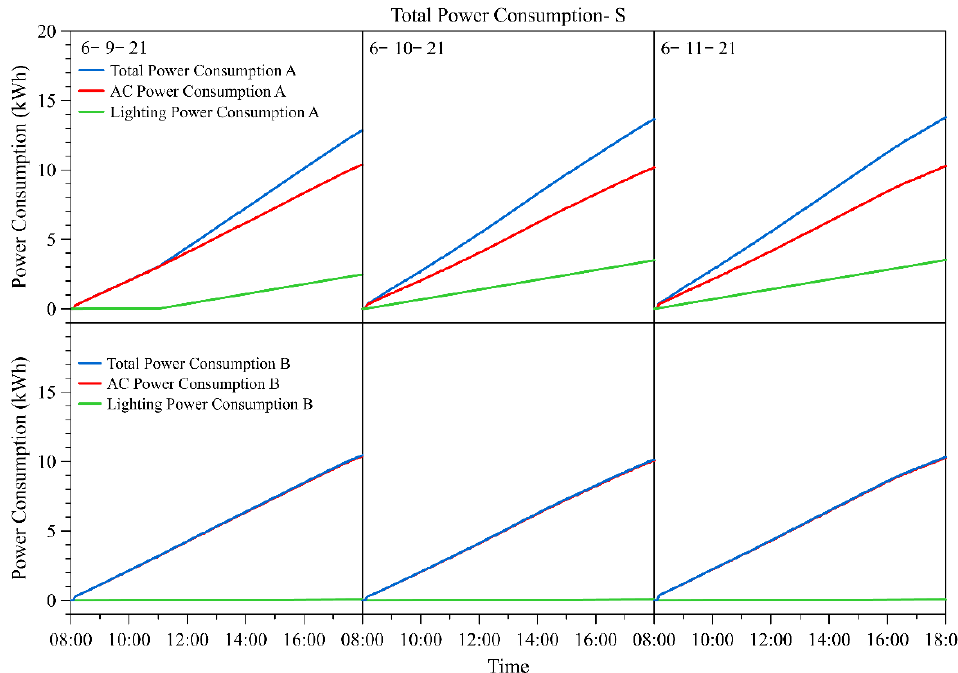
Figure 9. Cumulative power consumption record of South-facing window.